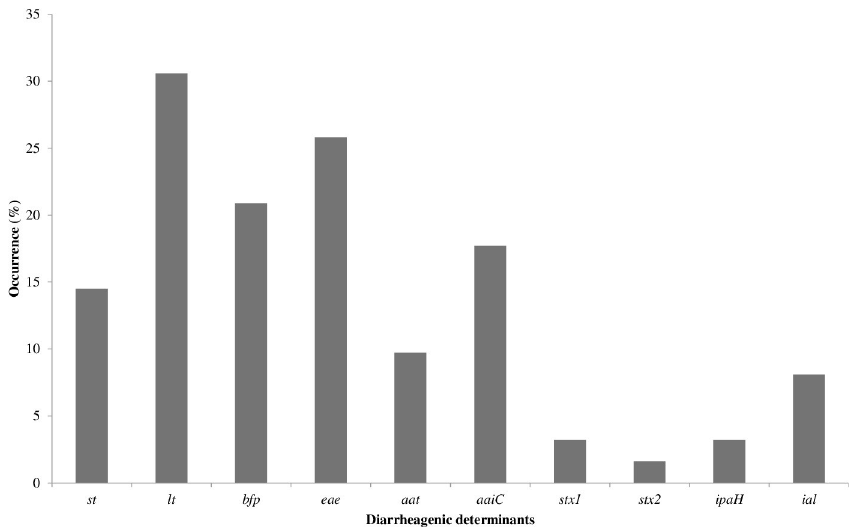
Fig 2. Diarrheagenic determinants of E . coli from processed RTE